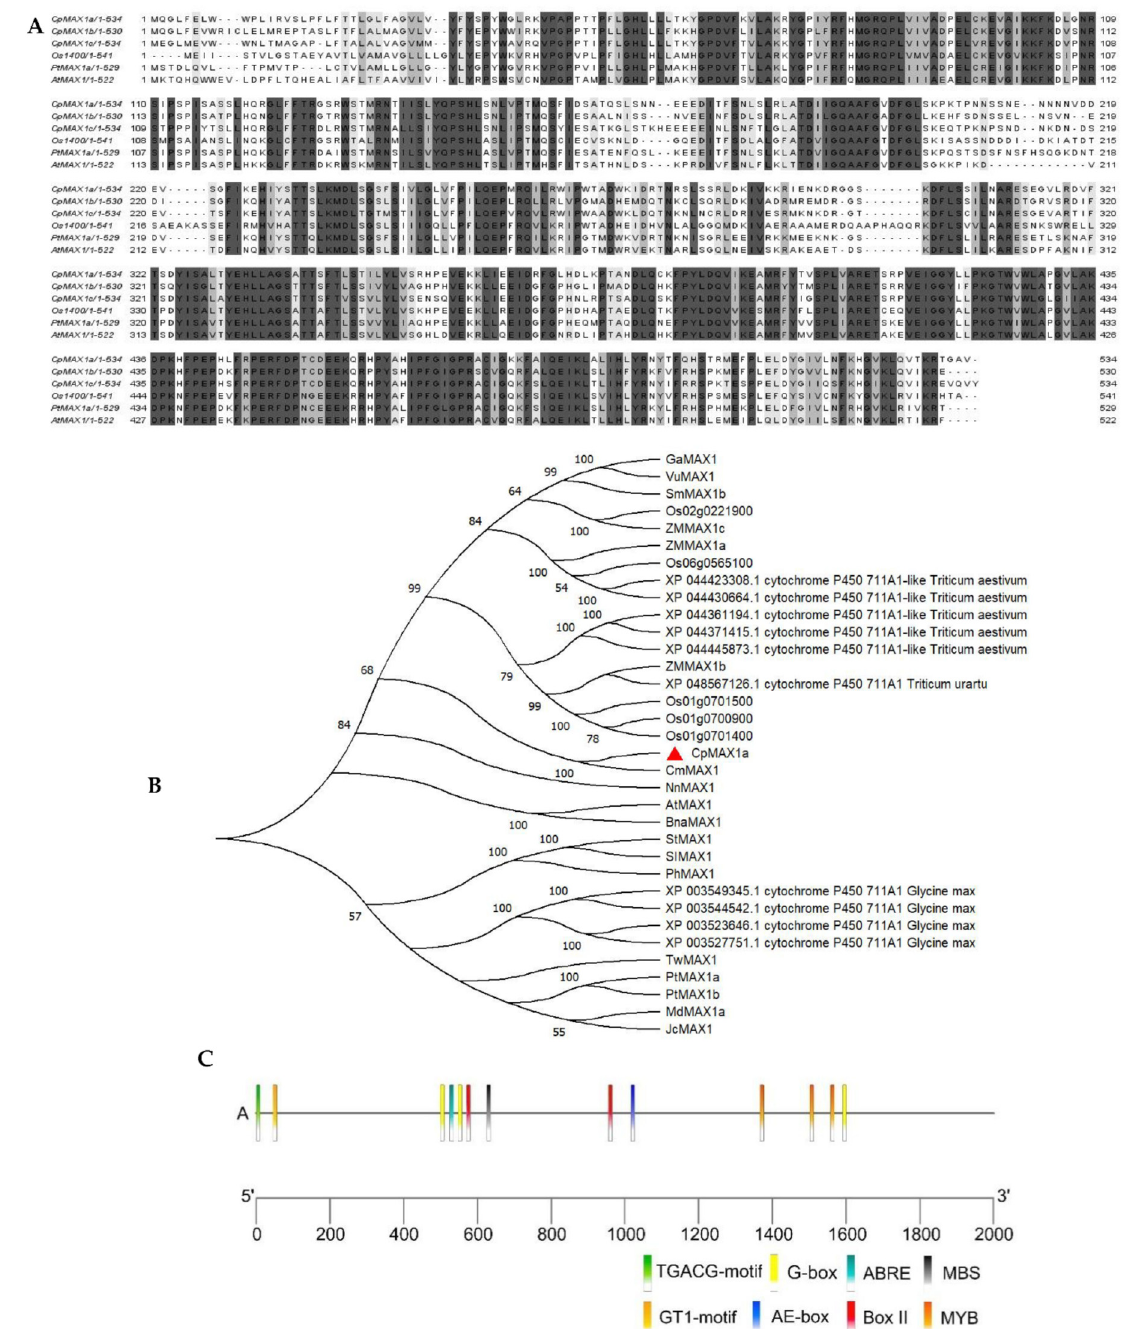
Figure 1. Characterization of CpMAX-1a gene in wintersweet. ( A ) Multiple sequence alignment of Cp- MAX1 proteins with MAX1 proteins from Oryza sativa (JX235696), Populus trichocarpa (XP_006372016), and Arabidopsis (AK316903). Identical amino acids are shaded in black, while similar amino acids are shaded in gray. ( B ) Phylogenetic analysis of CpMAX-1a and CYP711As in various plants. MEGA 11 software with the neighbor-joining (NJ) method (1000 bootstrap repeats) was used to reconstruct the phylogenetic tree. ( C ) Cis-acting elements in the promoter of CpMAX1a . Accession numbers of the protein sequences and analysis of cis-acting elements of promoters are shown in Tables S2 and S3,